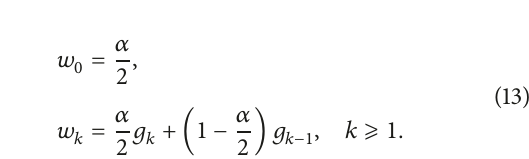
Figure 1: The finite difference stencil for point ( 𝑙 ,2n+1).